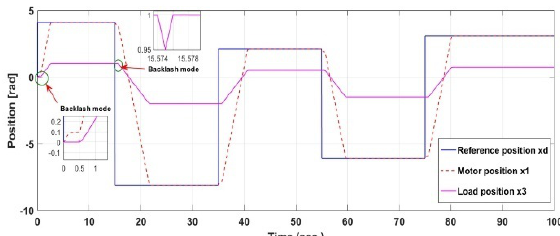
Figure 9. Desired position x 3 d and load position ( x 3 = θ l ) vs. time for the two-mass system connected by a gearbox